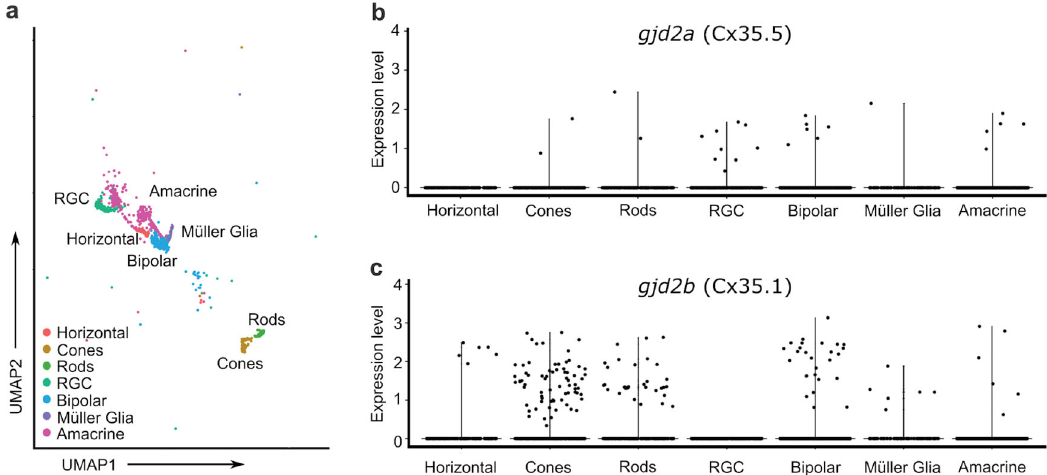
Fig. 7 Single-cell transcriptome analysis of larval WT zebra fi sh. Single-cell transcriptome analysis reveals gjd2a (Cx35.5) and gjd2b (Cx35.1) expression in a wide variety of retinal cell types. a Annotated retinal cell clusters isolated from a single-cell RNA-seq data set of 2 – 5 dpf larval zebra fi sh. b , c Expression of gjd2a (Cx35.5) ( b ) and gjd2b (Cx35.1) ( c ) in seven identi fi ed retinal cell clusters. Each dot represents an individual cell and its expression level of the indicated gene. UMAP uniform manifold approximation and projection, RGC retinal ganglion cell.